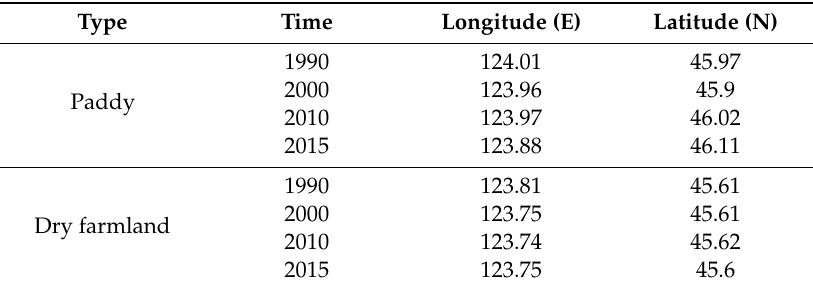
Table 4. Historical changes in gravity centers location.